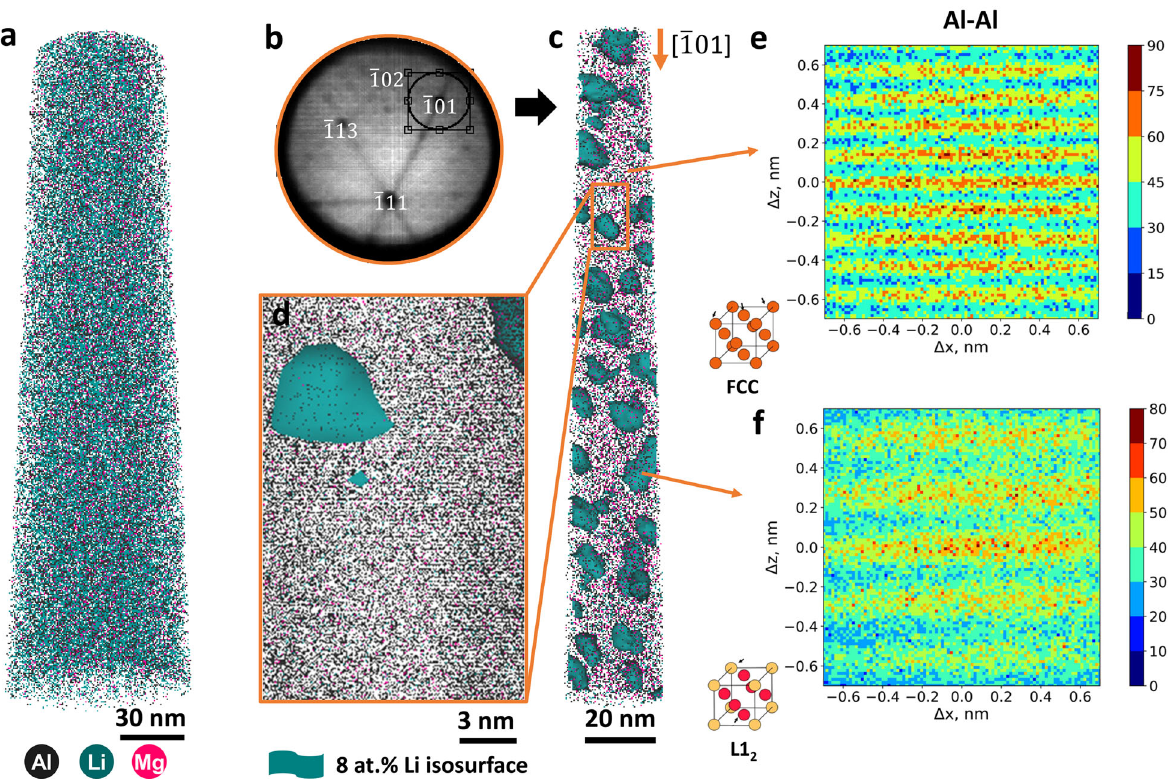
Fig. 1 APT data of Al – 5.18Mg – 6.79Li (at%) alloy. a 3D atom probe tomography; b 2D desorption map histogram; c reconstructed 3D atom probe tomography along [01] crystallographic pole; d a close-up of a thin slice in c ; examples of zx -SDMs along [01]: Al – Al interatomic vector